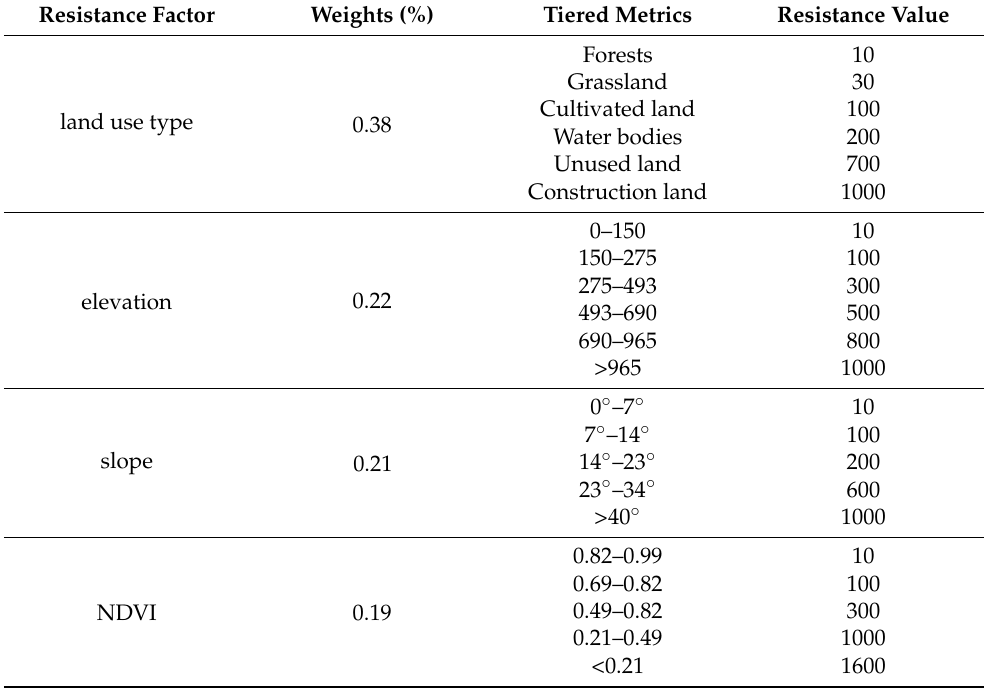
Table 1. Graded assignment of resistance factors and weight assignment. Resistance Factor Weights (%) Tiered Metrics Resistance Value